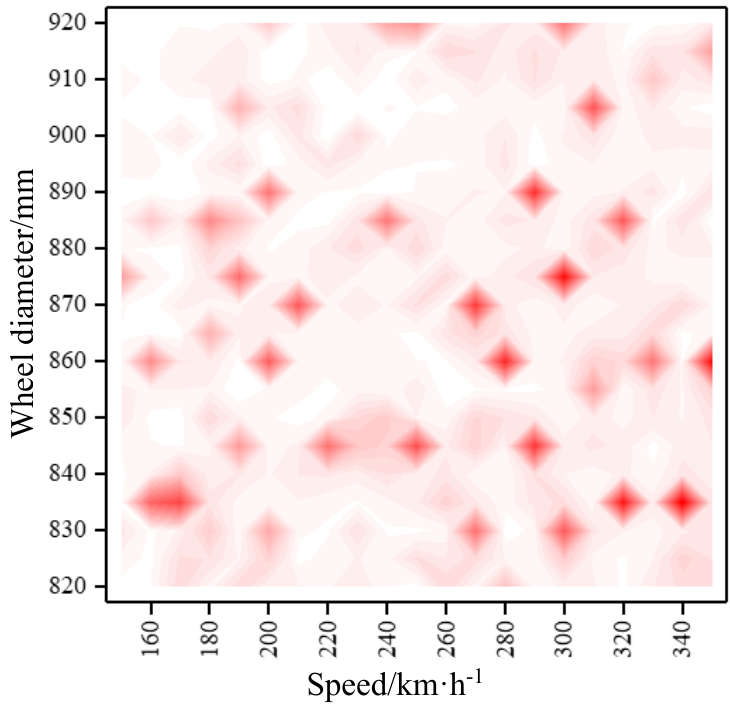
Figure 19. Polygonal wear development with different operation speeds and different wheel diameters.